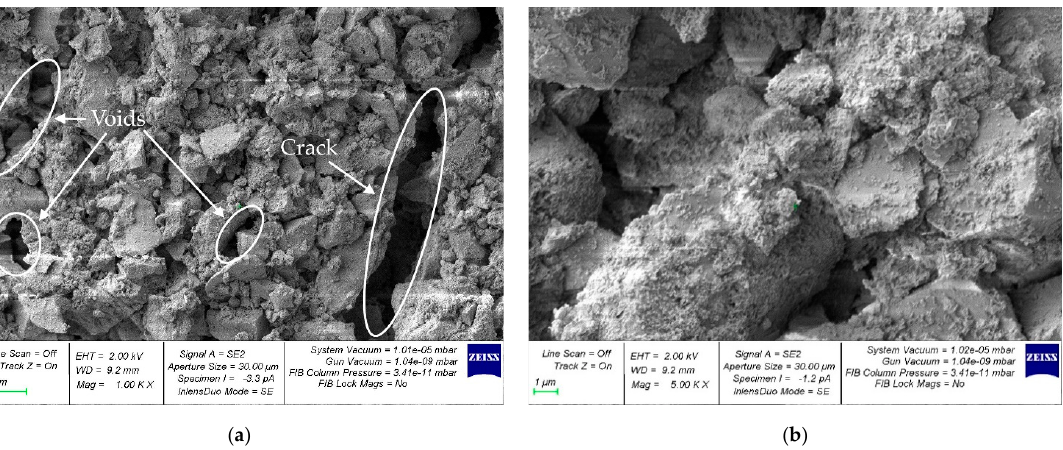
Figure 13. Micrographs of the structure of the hardened cement paste with partial replacement of mineral coarse aggregate with walnut shell, in the amount of 30%: ( a ) 1000×; ( b ) 5000×.